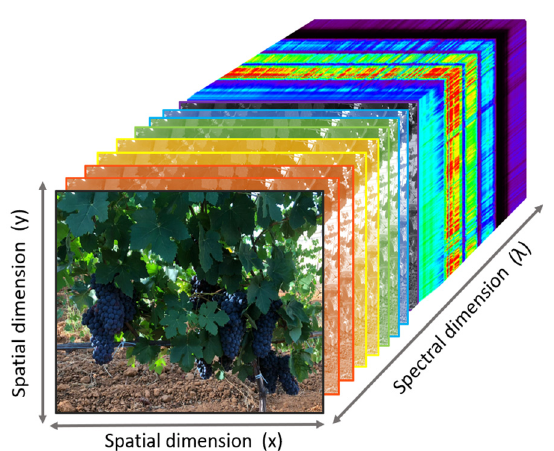
Figure 3. Representation of the three-dimensional hypercubic architecture of hyperspectral images of a vineyard canopy.